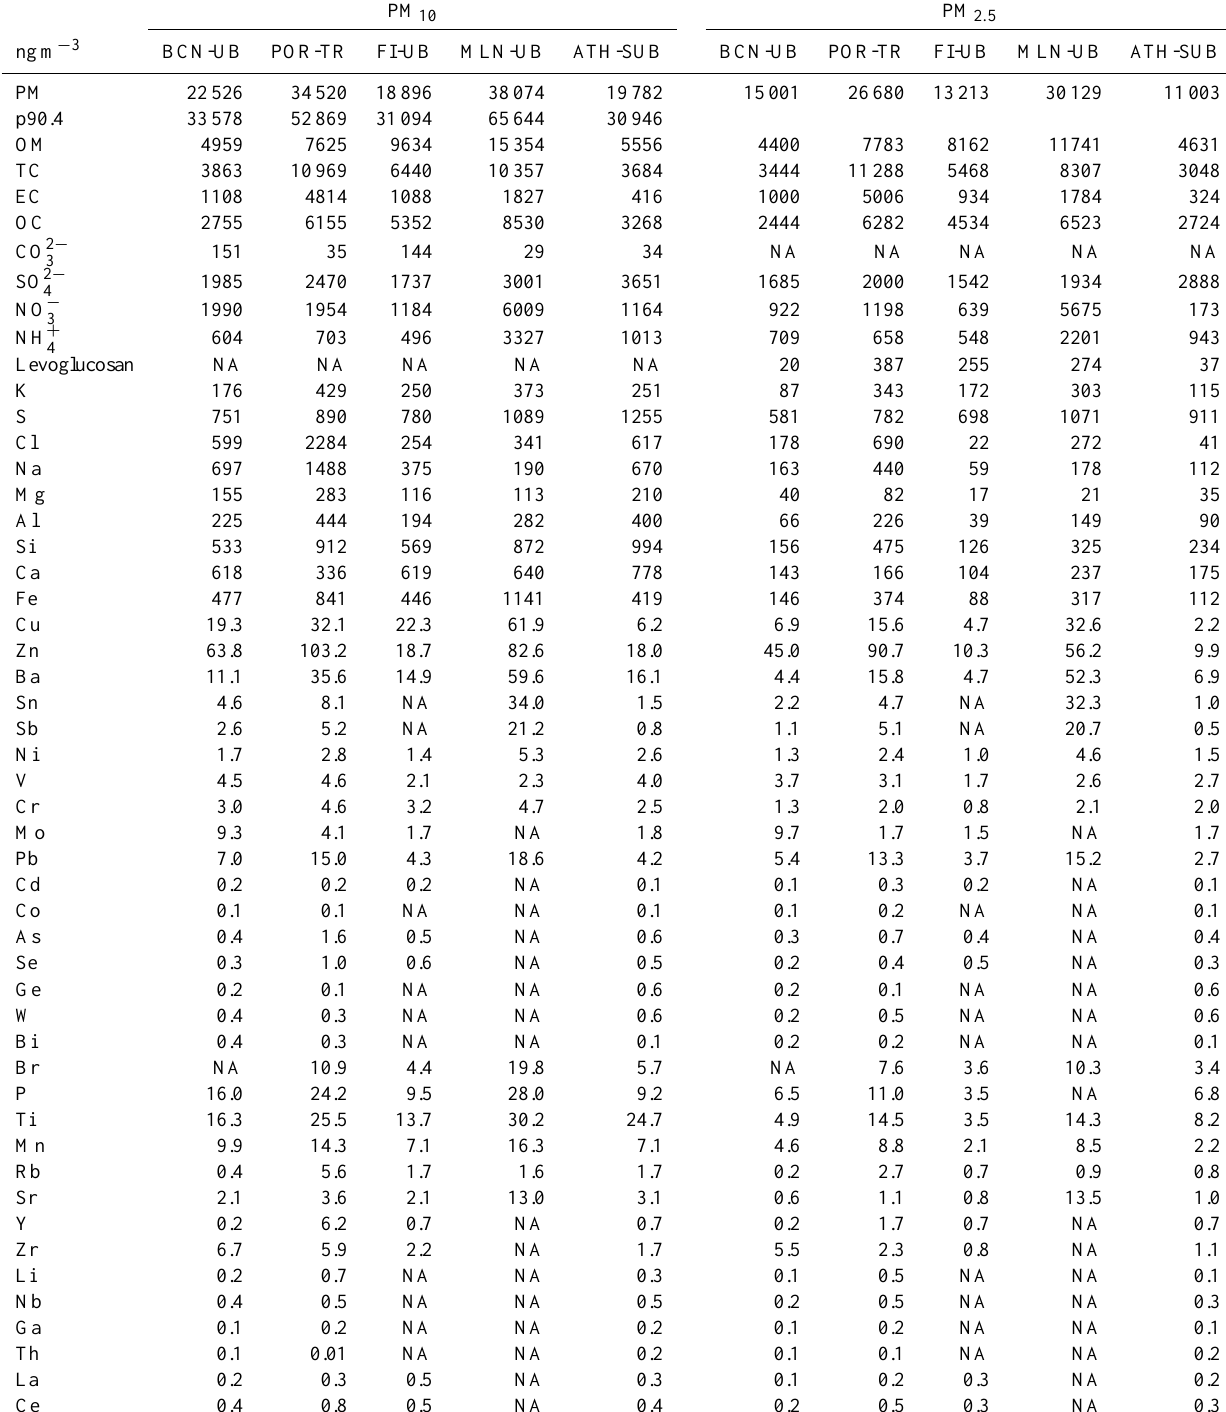
Table 1. Mean PM and component concentrations for the study period at the five AIRUSE cities. NA: not available. PM 10 PM 2 . 5 ngm −